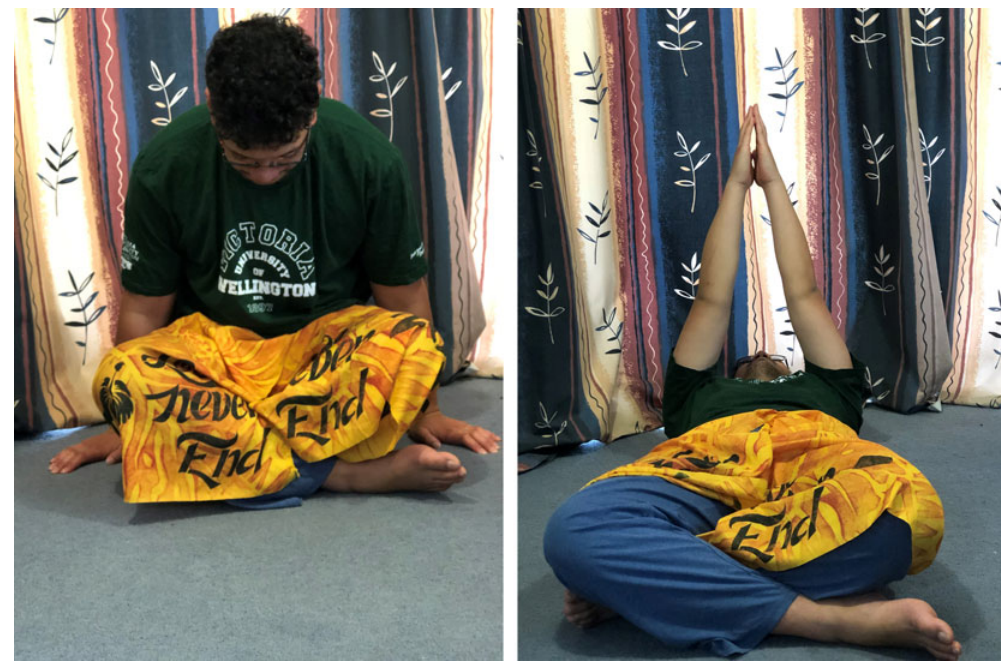
Fig. 3. Symmetry across the body.